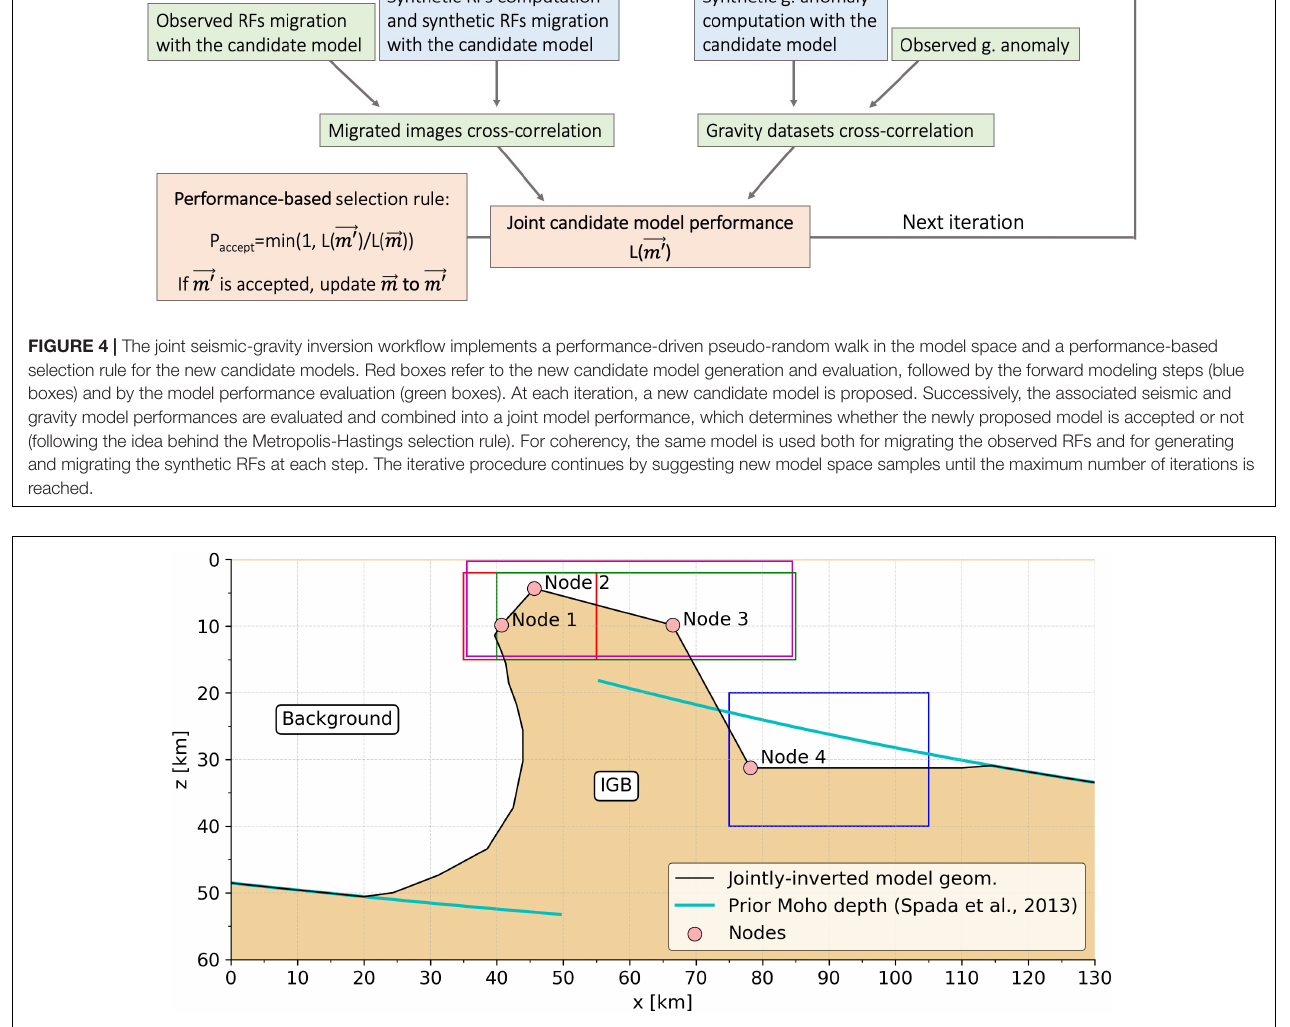
FIGURE 5 | Model parameterization of the IGB shape used for the joint inversion of seismic and gravity data. We invert for the 2D IGB interface geometry (black line), whose configuration depends on the coordinates of four nodes (red, magenta, green, and blue). Spatial positions of each node are investigated within a given perimeter (dashed boxes of respective color) during the inversion, together with the velocity and density contrast of the IGB relative to the surroundings. The far-field model geometry connects to the Moho map (Spada et al., 2013). In the East, the connection is by a horizontal line. In the West, the curved shape is taken from the earlier 3D gravity model of (Scarponi et al. (2020)), as the vertical wall cannot be resolved by converted seismic